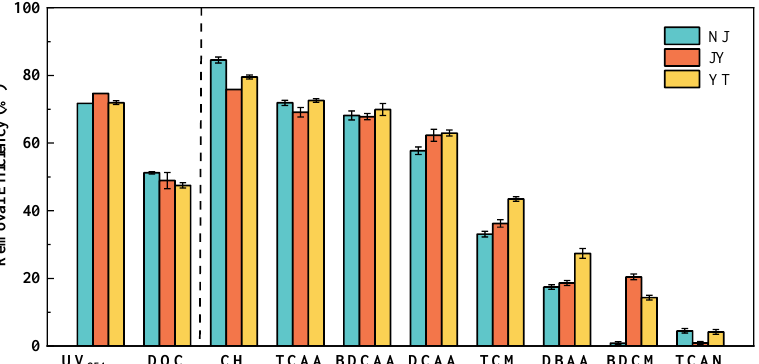
Figure 11. Effect of different water qualities on the adsorption of natural organic matter (NOM) onto RGO-SiO 2 . Table 3. Basic water quality parameters of experiment water.